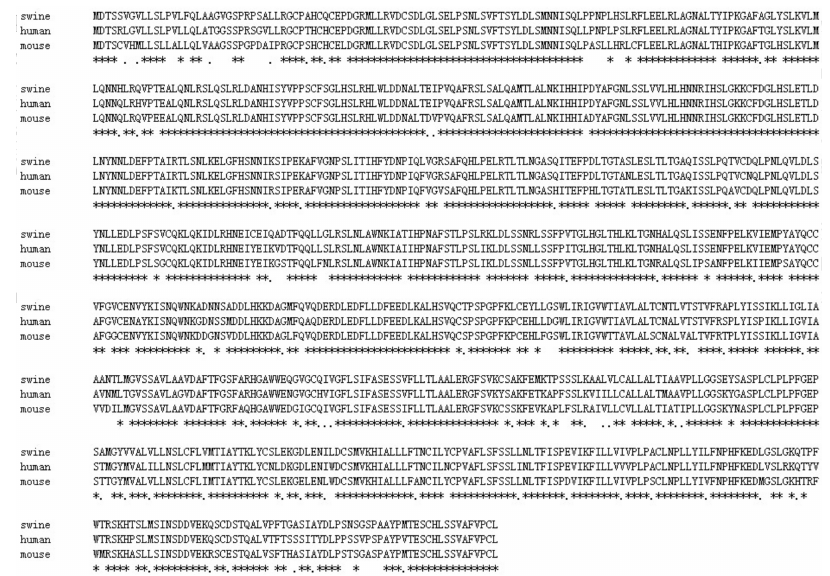
Figure 2. Comparison of the mouse, human and pig LGR5 protein sequences. The pig LGR5 protein was predicted from the cloned nucleotide sequence via DNASTAR (www.dnastar.com), and the comparison was conducted with the same software. * indicates the same amino acid residue.